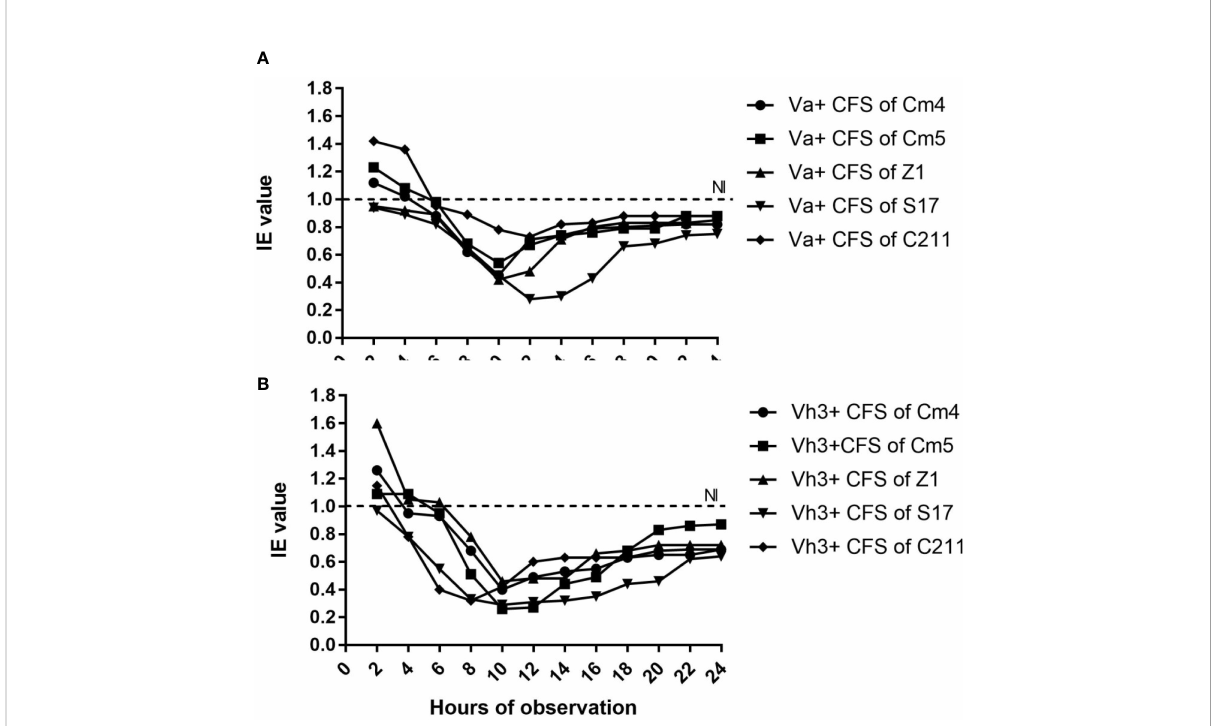
FIGURE 2 Inhibition ef fi ciency (IE) of selected strains against (A) Vibrio anguillarum CECT4344 (Va) and (B) V.harveyi Lg 26/01 (Vh3) as a function of time. *IE ˃ 1 indicated growth promotion of pathogen, IE=1indicated no inhibition (NI) and IE<1 indicated inhibition of pathogen by CFS of selected